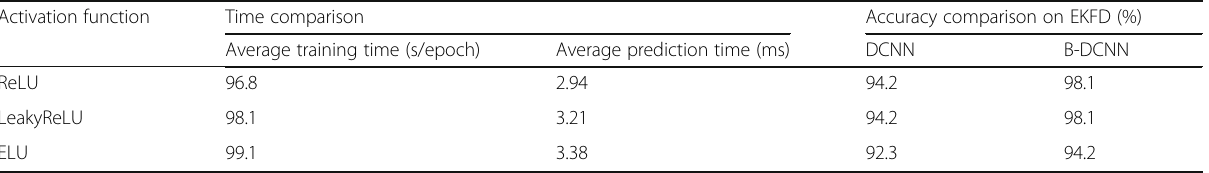
Table 3 Comparison of different activation functions tested on proposed B-DCNN Arc-2 model on EKFD Activation function